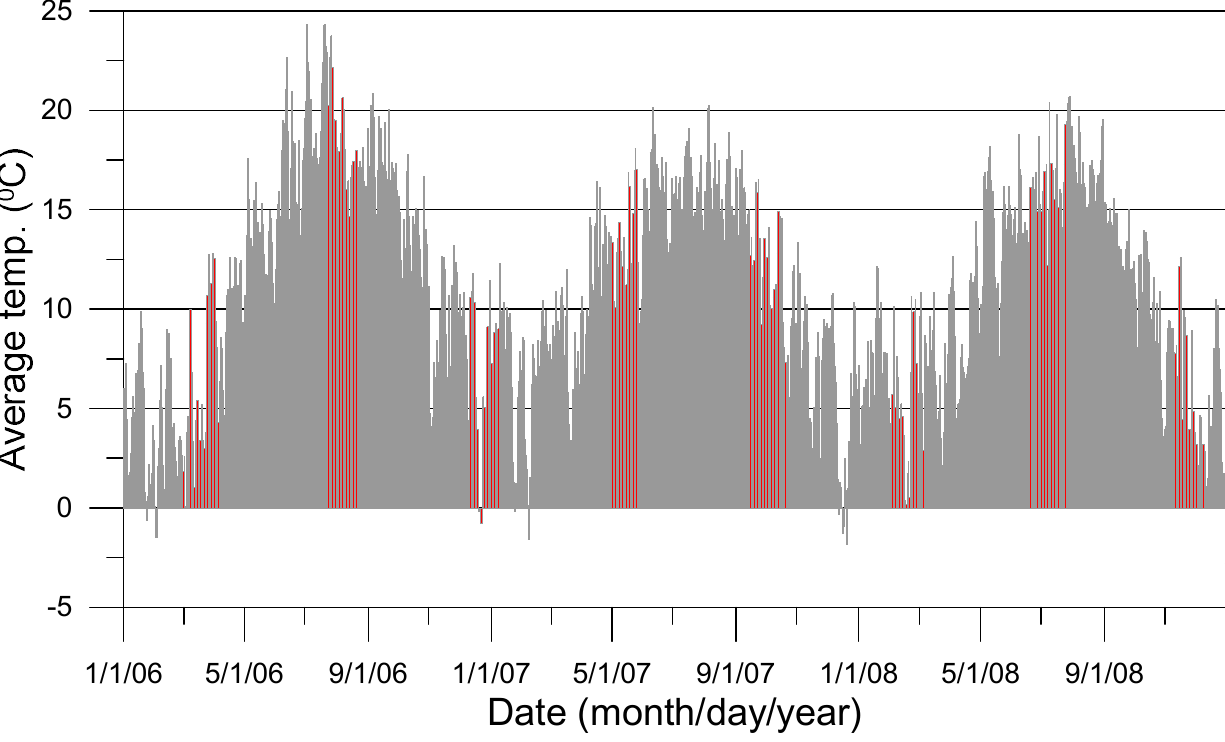
Figure A2. Average daily wind speed 2 m above the ground level at Newbury cutting.